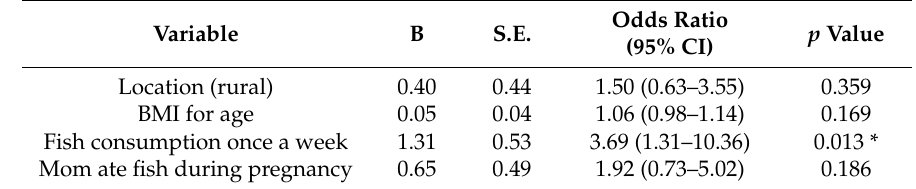
Table 3. Factors attributed to high mercury